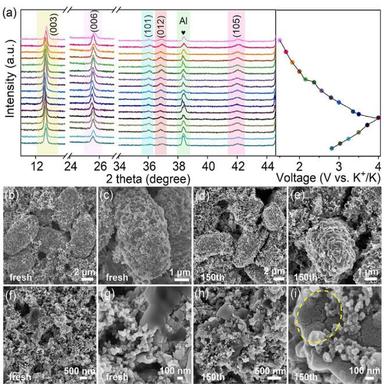
(a) Ex-situ XRD patterns of the KMNO cocoon electrode collected during the first charge/discharge at 20 mA g1 in the voltage range of 1.5–4.0 V. SEM images of (b and c) the fresh KMNO cocoon electrode and (d and e) the KMNO cocoon electrode after 150 cycles. SEM images of (f and g) the fresh KMNO particle electrode and (h and i) the KMNO particle electrode after 150 cycles.